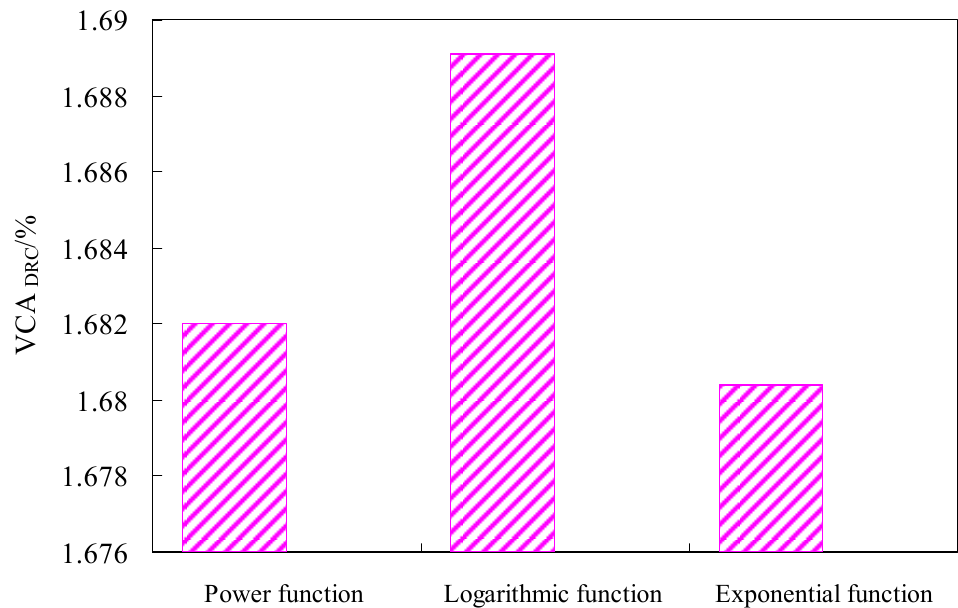
Figure 2. Tests results of bulk density and void ratio for three gradations.